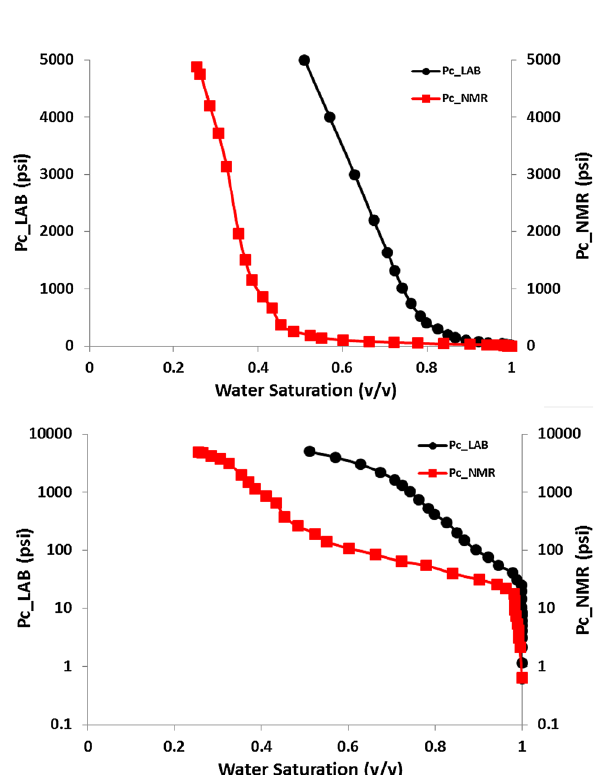
Fig. 16 T 2 relaxation plot for the channel storey axis unit for a fully saturated sample. The green dash lines indicates the cut-offs for esti- mating the FFI, BVI, corresponding S wirr and total porosity deter- mined from the sum of amplitudes